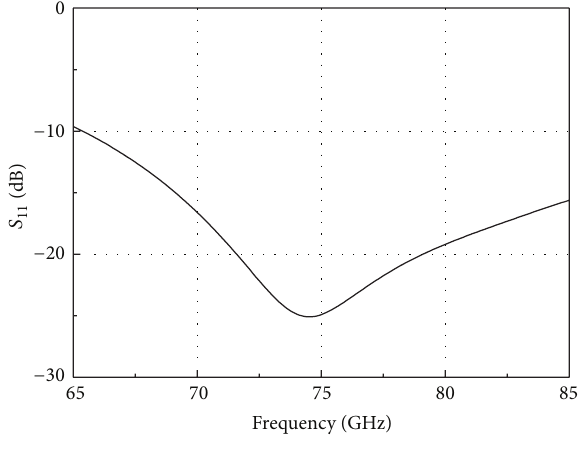
Figure 11: 𝑆 11 of the proposed antenna. Table 1: Realized gains of the proposed antenna backed by AMC with different element numbers.